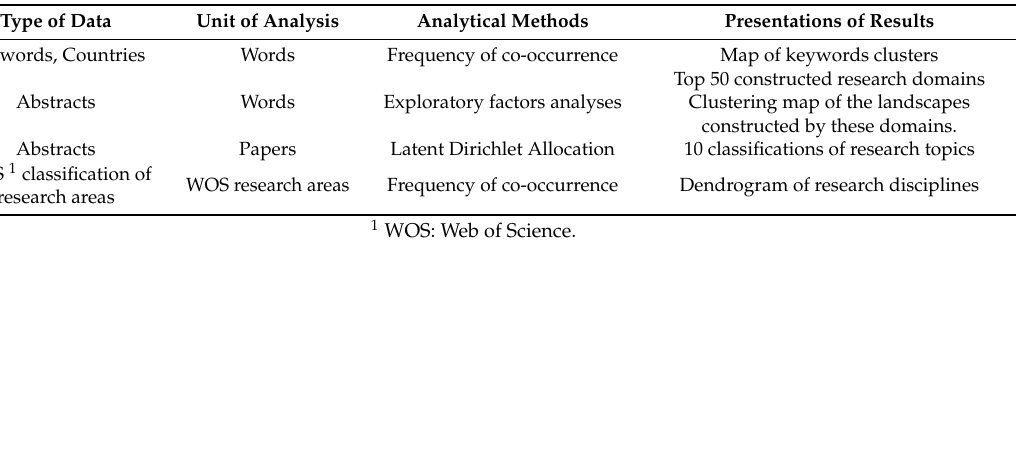
Table 1. Overview of analytical techniques utilized for each data type. WOS, Web of